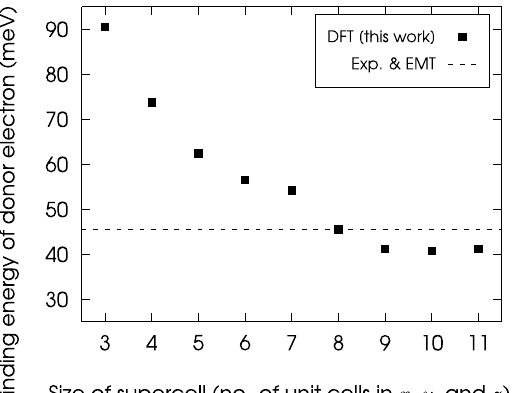
Figure 6. Binding energies for the s A 1 ( ) state of a phosphorus donor electron in silicon, calculated by the 1 method described in this section, for supercells that range in size from 216 to 10,648 atoms. The accepted value for the binding energy, taken from ref. 19, is shown as a dashed